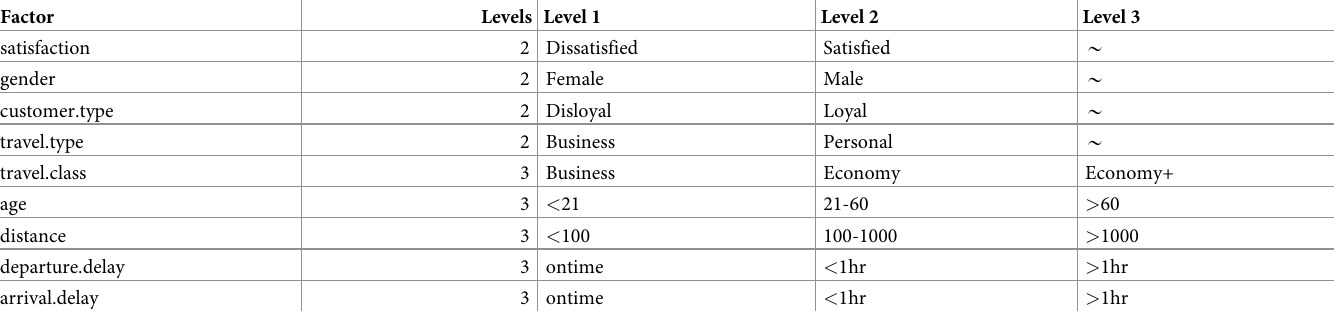
Table 4. Demographic groups in this research defined by factors and